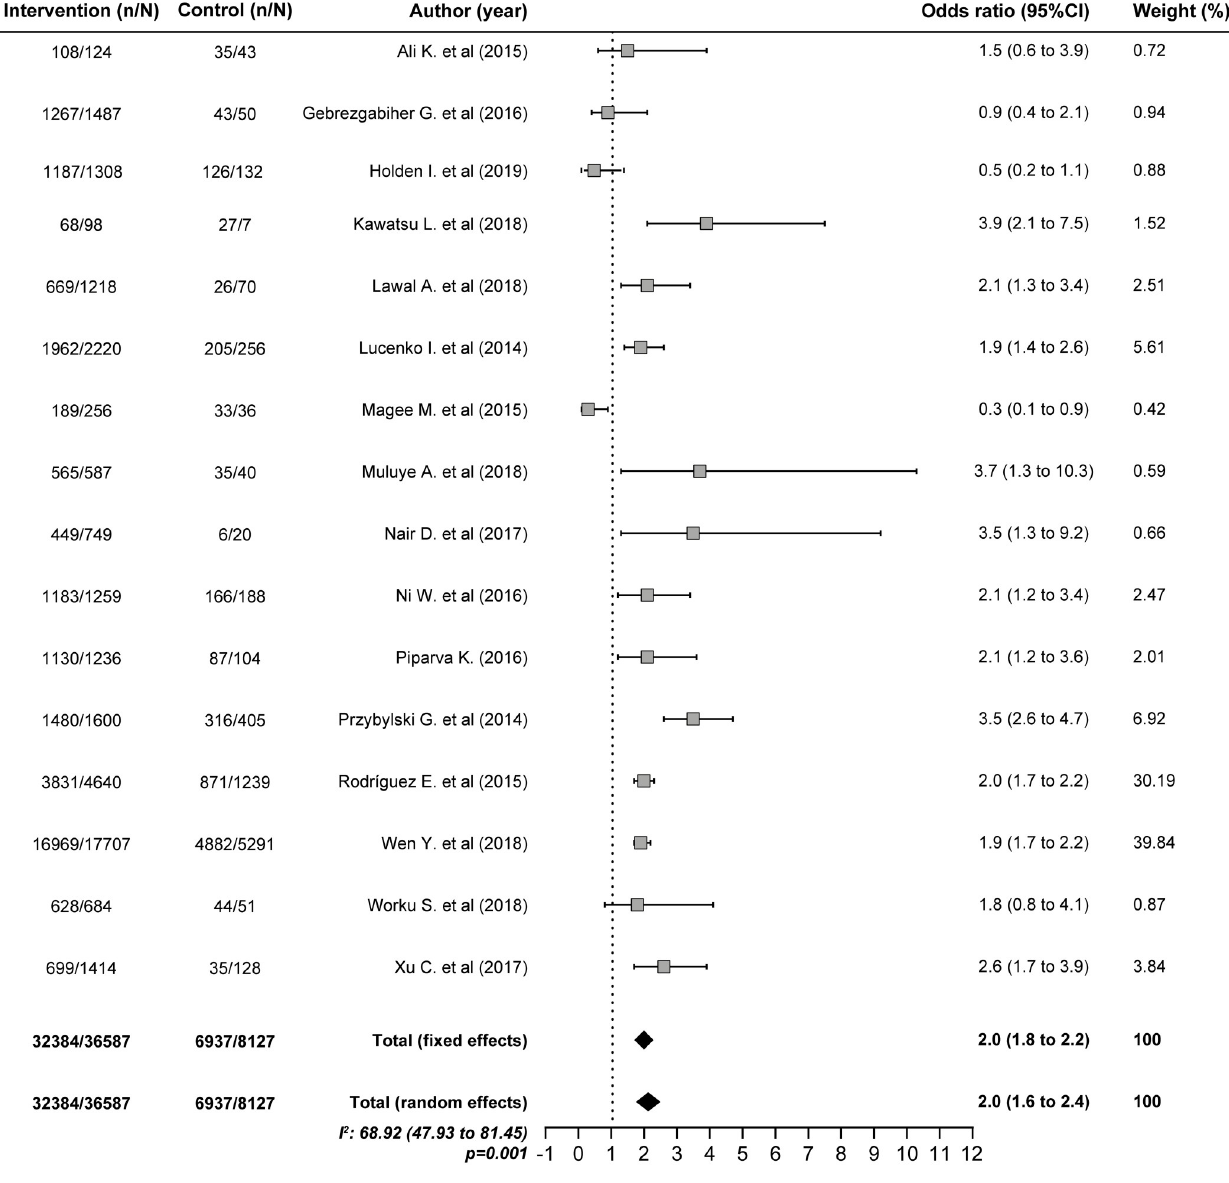
Fig 4. Pooled estimate to age < 65 years as a factors predictive of favorable outcomes of tuberculosis treatment.